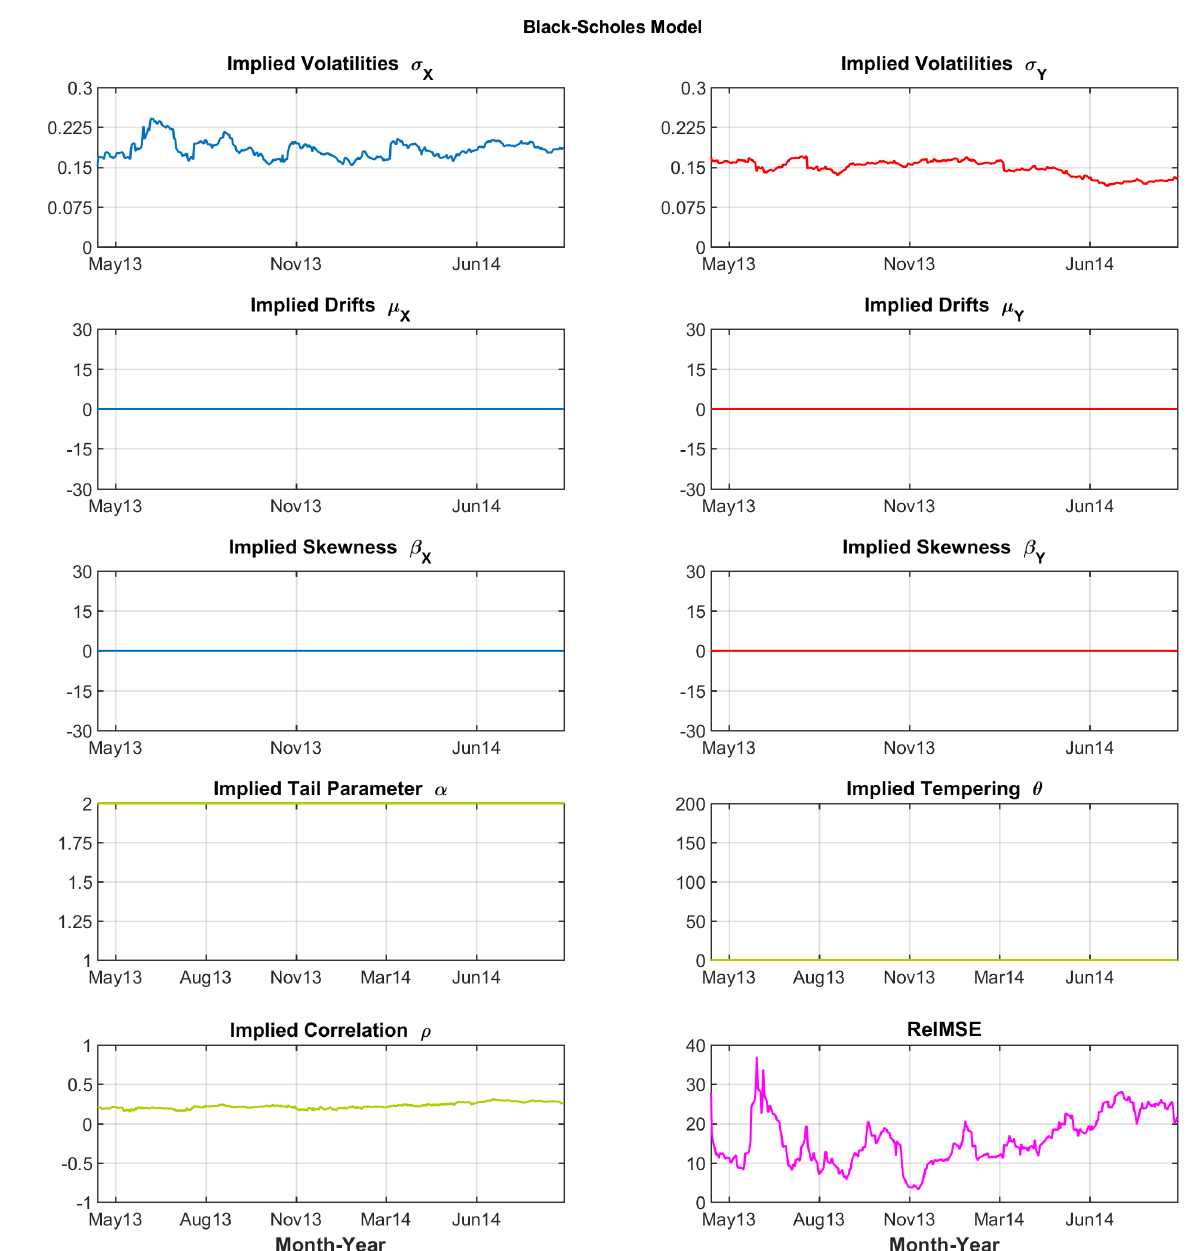
Figure 5. Quanto Calls: daily calibrated Black–Scholes parameters and RelMSE. Sample period 16 April 2013 to 15 September